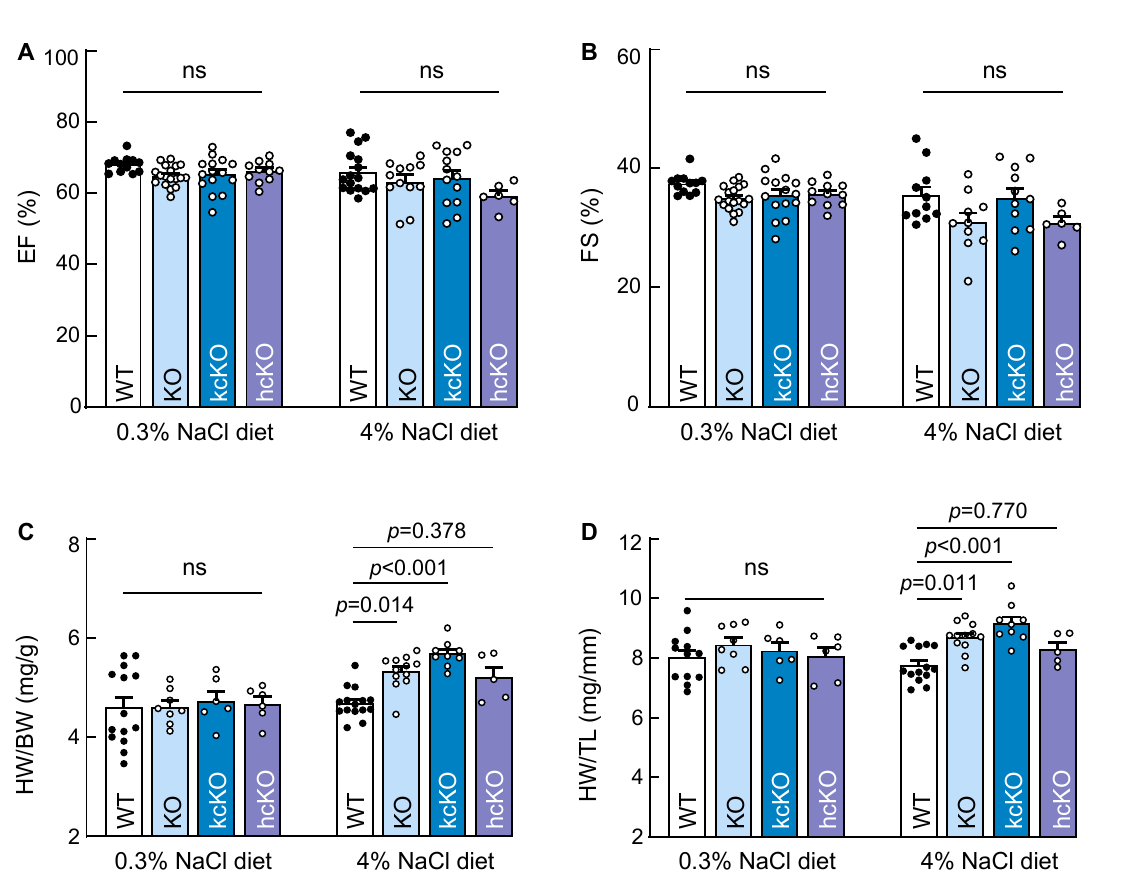
Figure 7. Cardiac hypertrophy in corin KO and kcKO mice on 4% NaCl diet. ( A , B ) Cardiac function, indicated by ejection fraction (EF) ( A ) and fraction shortening (FS) ( B ), was measured by echocardiography in male WT (black dots), corin KO, kcKO, hcKO (white dots) mice on 0.3% NaCl diet and 4% NaCl diet for three weeks. n = 6–18 per group. ( C , D ) Cardiac hypertrophy was assessed by ratios of heart weight (HW) to body weight (BW) ( C ) or tibia length (TL) ( D ) in male WT (black dots), corin KO, kcKO, hcKO (white dots) mice on 0.3% NaCl diet and 4% NaCl diet for three weeks. n = 5–15 per group. Data shown are mean ± SEM. p Values were analyzed by one-way ANOVA. ns, not significant.